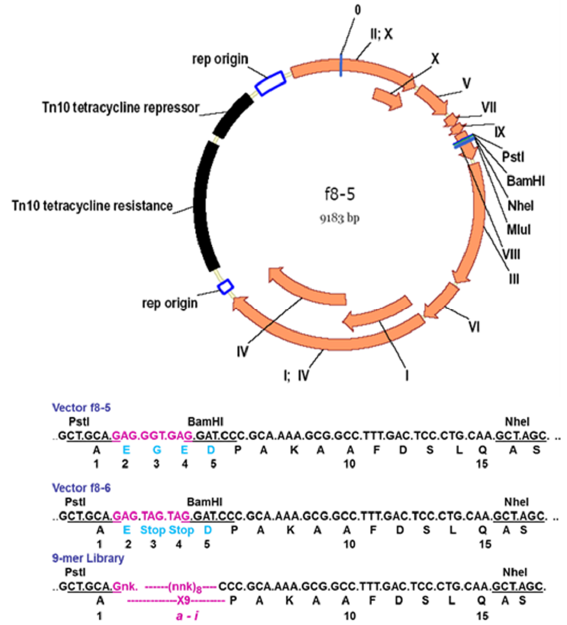
Figure 6. Phage display peptide libraries for vectors f8-5/f8-6 and f8-6. Characteristics of f8-6 vector: Restriction sites Pst I, Bam HI, Nhe I, and Mlu I in pVIII gene; Tet resistance gene spliced in origin of replication; low copy number of RF DNA and phages/cell; formation of tiny plaques on Tet-negative and colonies on Tet-positive agar plates.